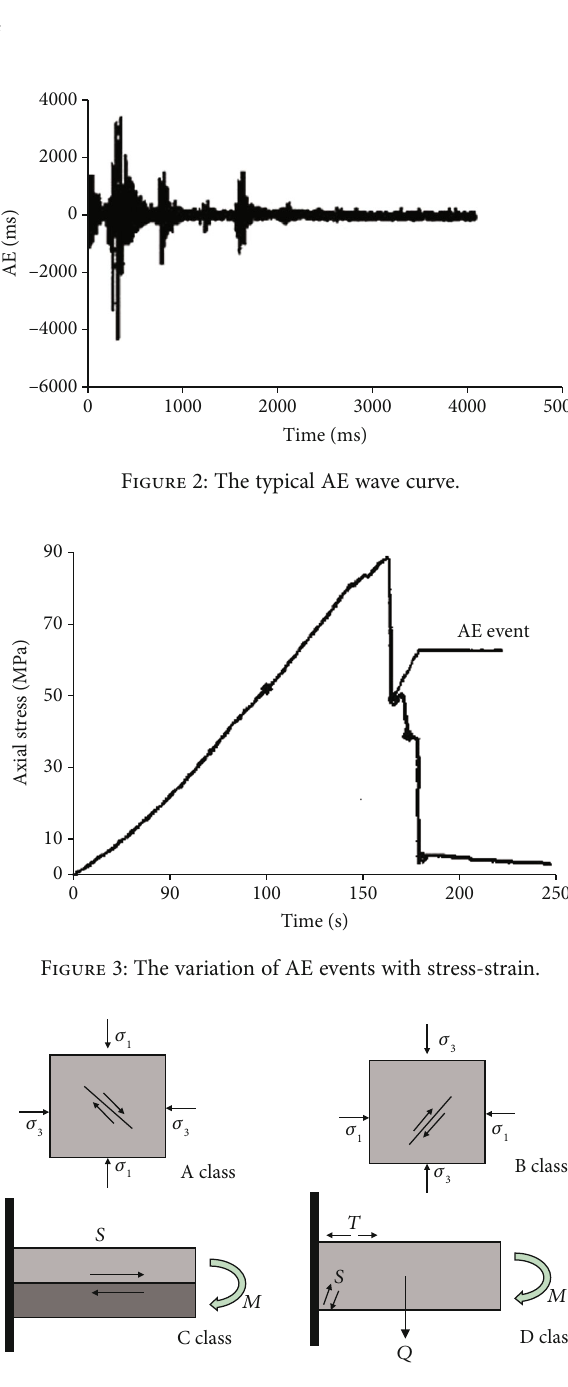
Figure 4: Mechanical mechanism of rock fracture resulting from excavation. Figure 5. This information is also called the characteristic parameter of acoustic emission.